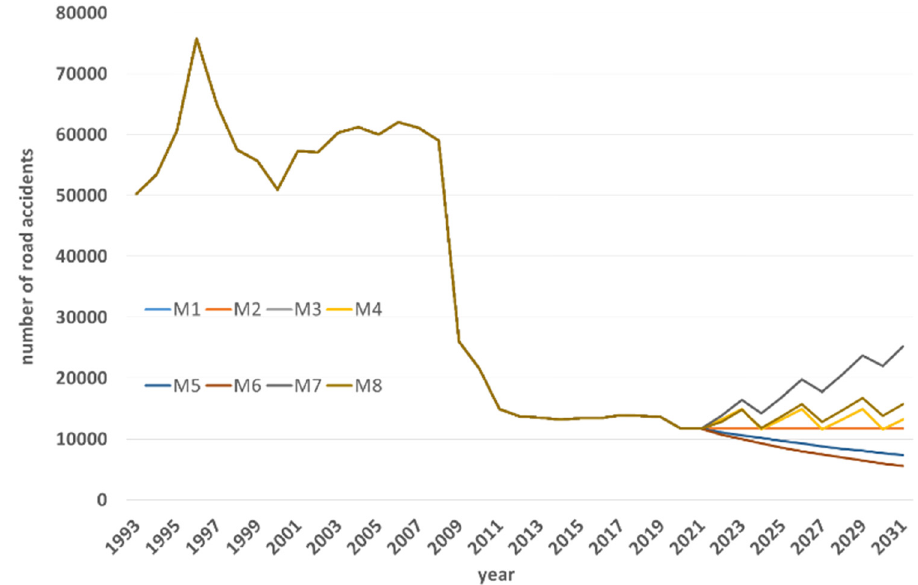
Figure 6: Forecasting the number of road accidents in Slovakia from 2022 to 2031 ( M1 – no trend – ME; M2 – no trend SSE; M3 – no trend additive ME; M4 – no trend additive SSE; M5 – exponential model ME; M6 – exponential SSE; M7 – exponential additive ME and M8 – exponential additive SSE ) .